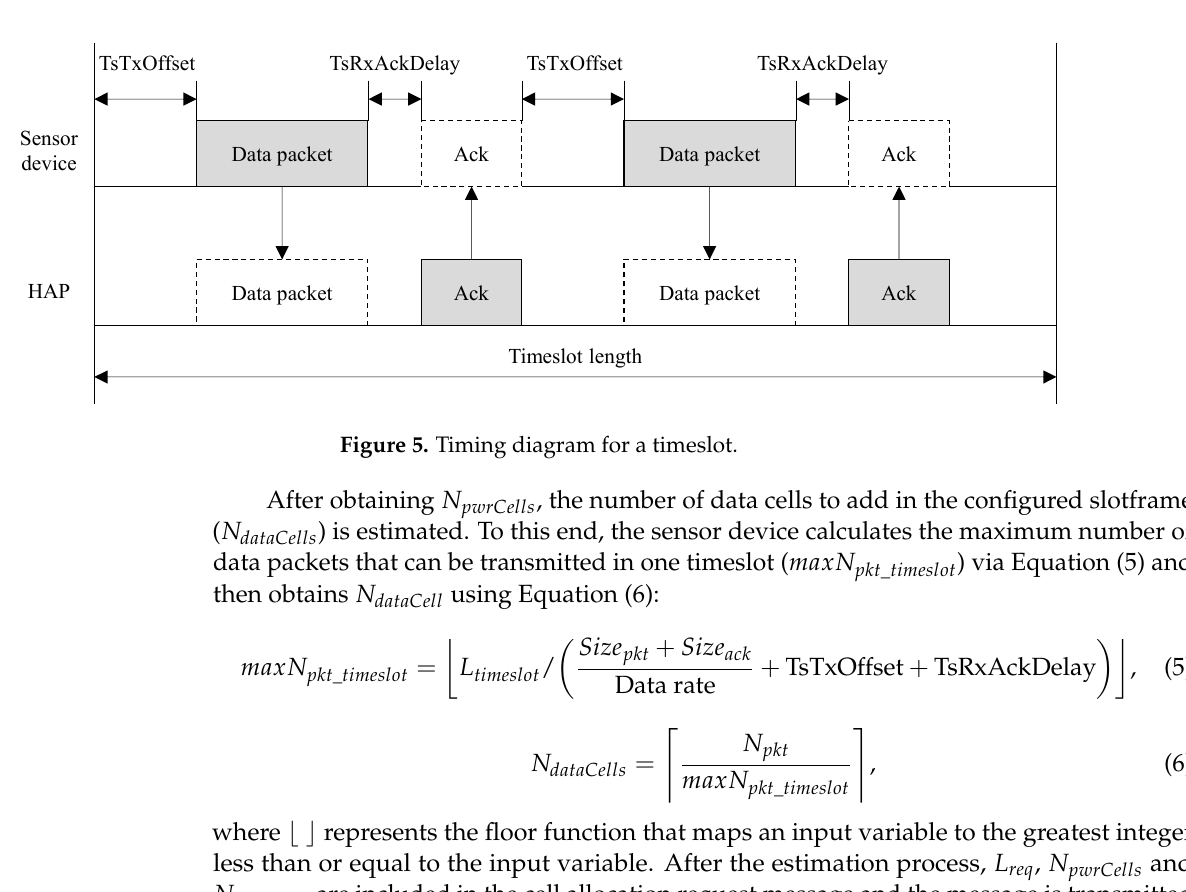
Figure 4. Overall operation of TMSS.